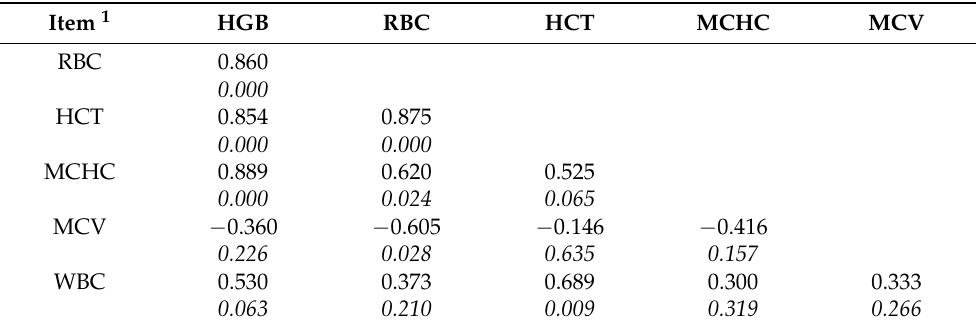
Table 3. Correlation coefficients ( ρ ) and significance ( p -value in italics below ρ ) between selected parameters of CBC at Pearson’s test.